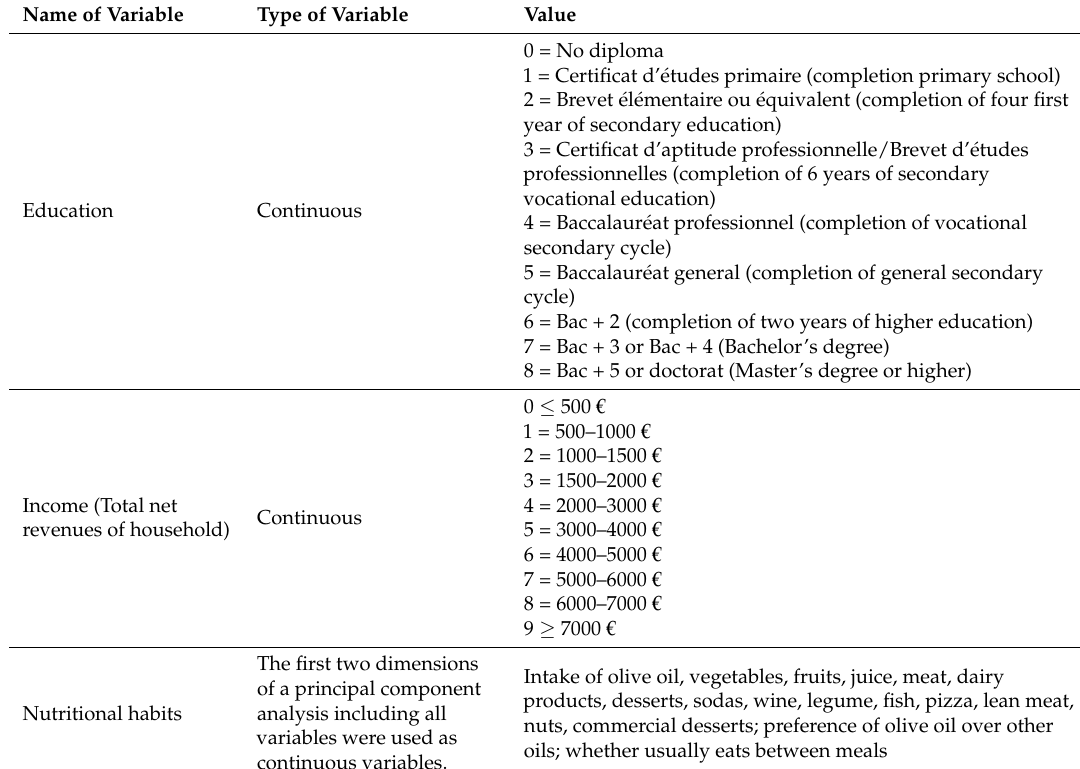
Table A2. Potentially confounding variables controlled for in the